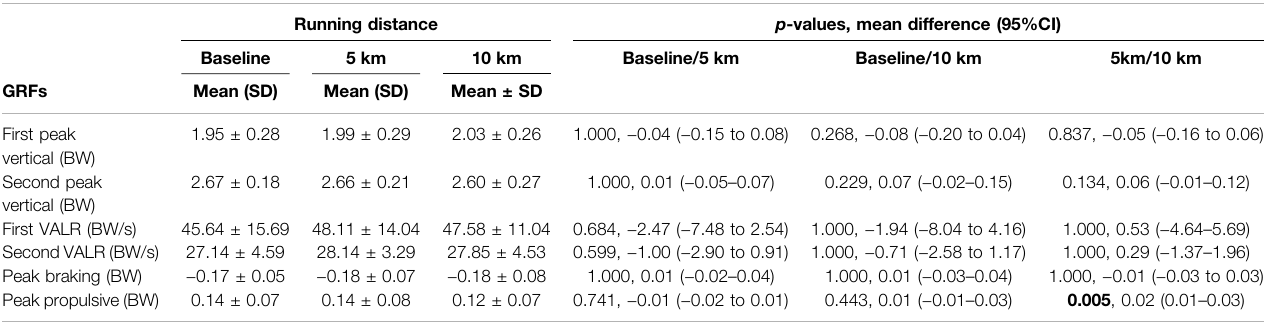
TABLE 4 | Ground reaction forces at baseline and immediately after 5 and 10 km of